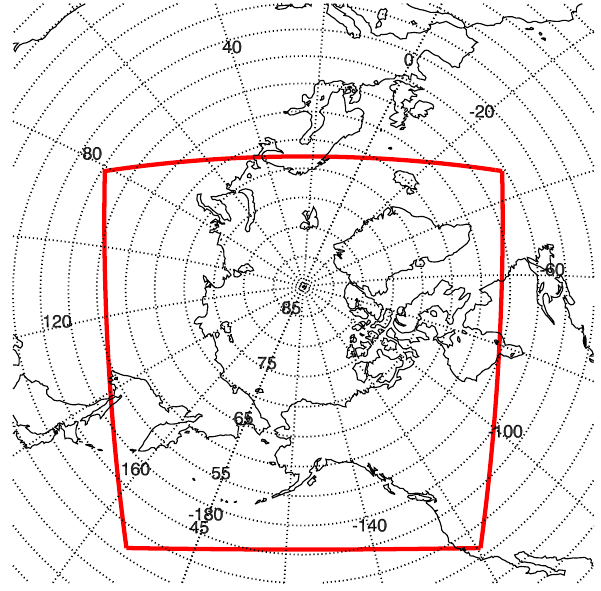
Figure 2. The WRF model domain (red